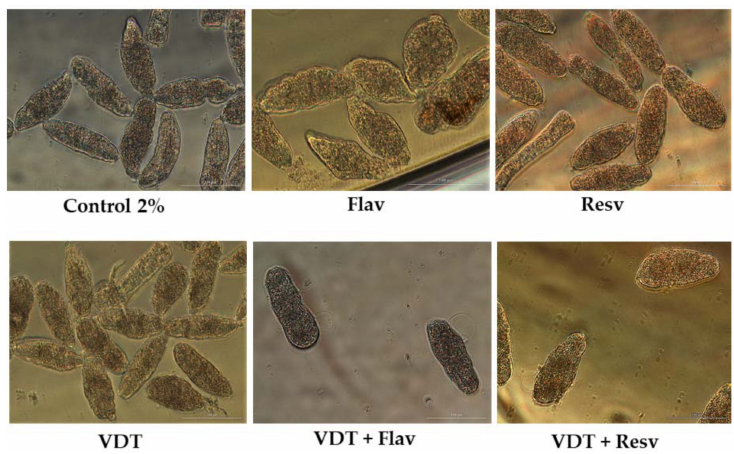
Figure 5. Representative micrographs of NTS at 72 h of incubation in VDT, Flav and Resv either alone or combined at 100 µ M and 1:1 constant ratio; scale bar, 100 µ m.